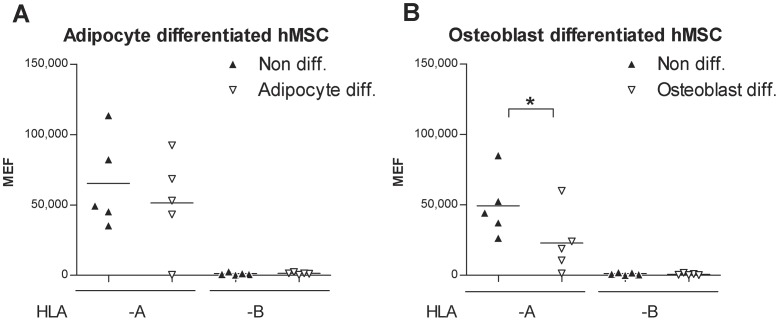
Expression of HLA-A and HLA-B on hMSC and in their differentiated adipocyte and osteoblast progenies.Locus-specific HLA antigen expression before and after 13 days of differentiation of hMSC to adipocytes (A), or 16 days of differentiation to osteoblasts (B) in one hMSC-Tert4 cell line and three primary hMSC cell lines (Table 1). The analyzed HLA-A alleles were HLA-A2 (N = 3) and -A3 (N = 2). The analyzed HLA-B alleles were HLA-B7 (N = 3), -B27 (N = 1) and -B8 (N = 1) (data pooled according to locus, each data point represents mean value for 3 experiments for each cell line).